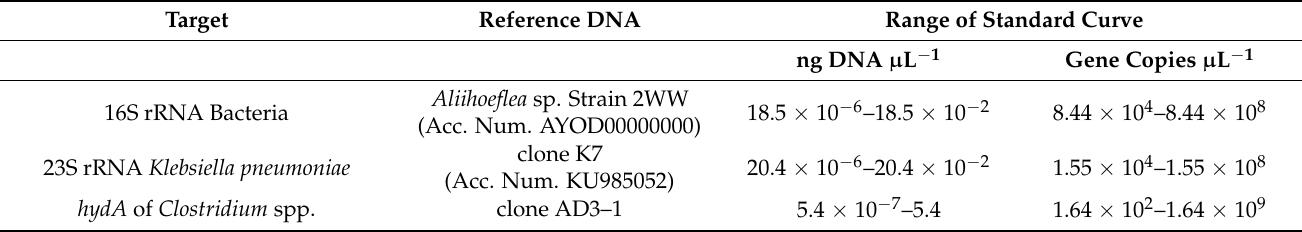
Table 2. Range of concentrations for reference DNAs used to generate standard curves. Target Reference DNA Range of Standard